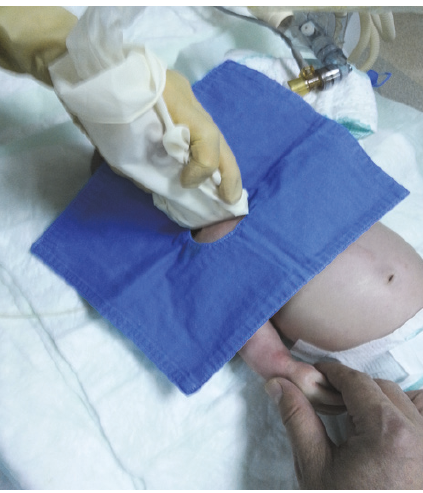
Figure 1: The position of the patient and ultrasound transducer during cannulation.